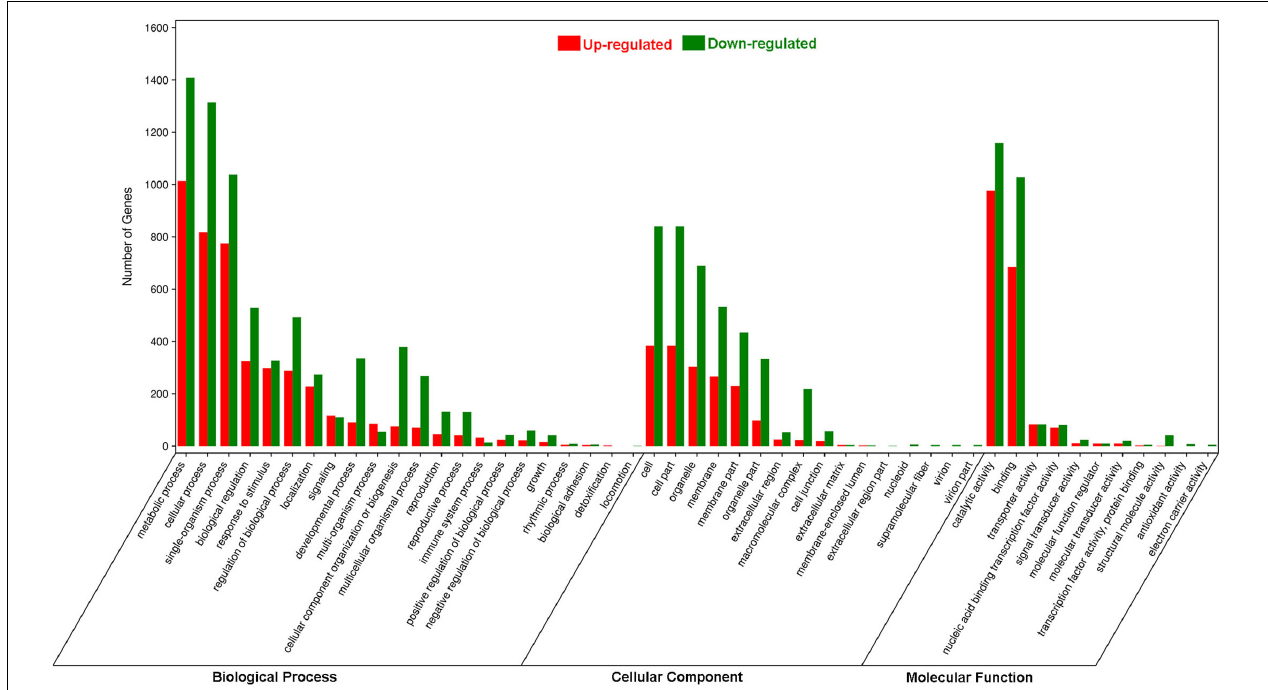
FIGURE 1 | Gene Ontology enrichment analysis of differentially expressed genes (DEGs) in Gossypium barbadense leaves after Helicoverpa armigera infestation. The DEGs were judged as differentially expressed when log 2 | Ratio| ≥ 1 with FDR ≤ 0.05.